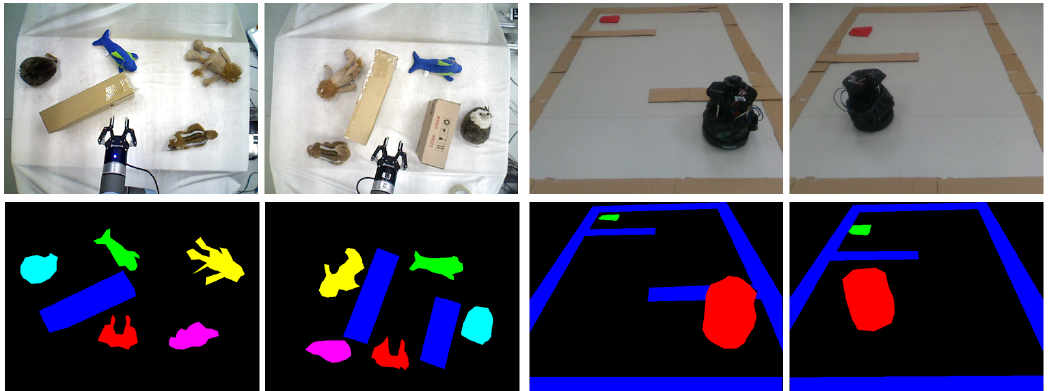
Figure 5. Sematic segmentation results of robot working scenarios. The first row shows the RGB images, and the second row shows their corresponding semantic images. The left two are for the manipulation task, and the right two are for the navigation task. Best viewed in